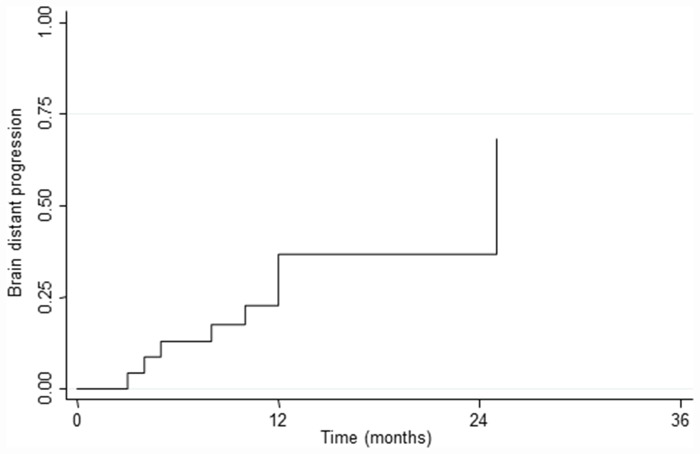
Incidence of brain distant progression (BDP).